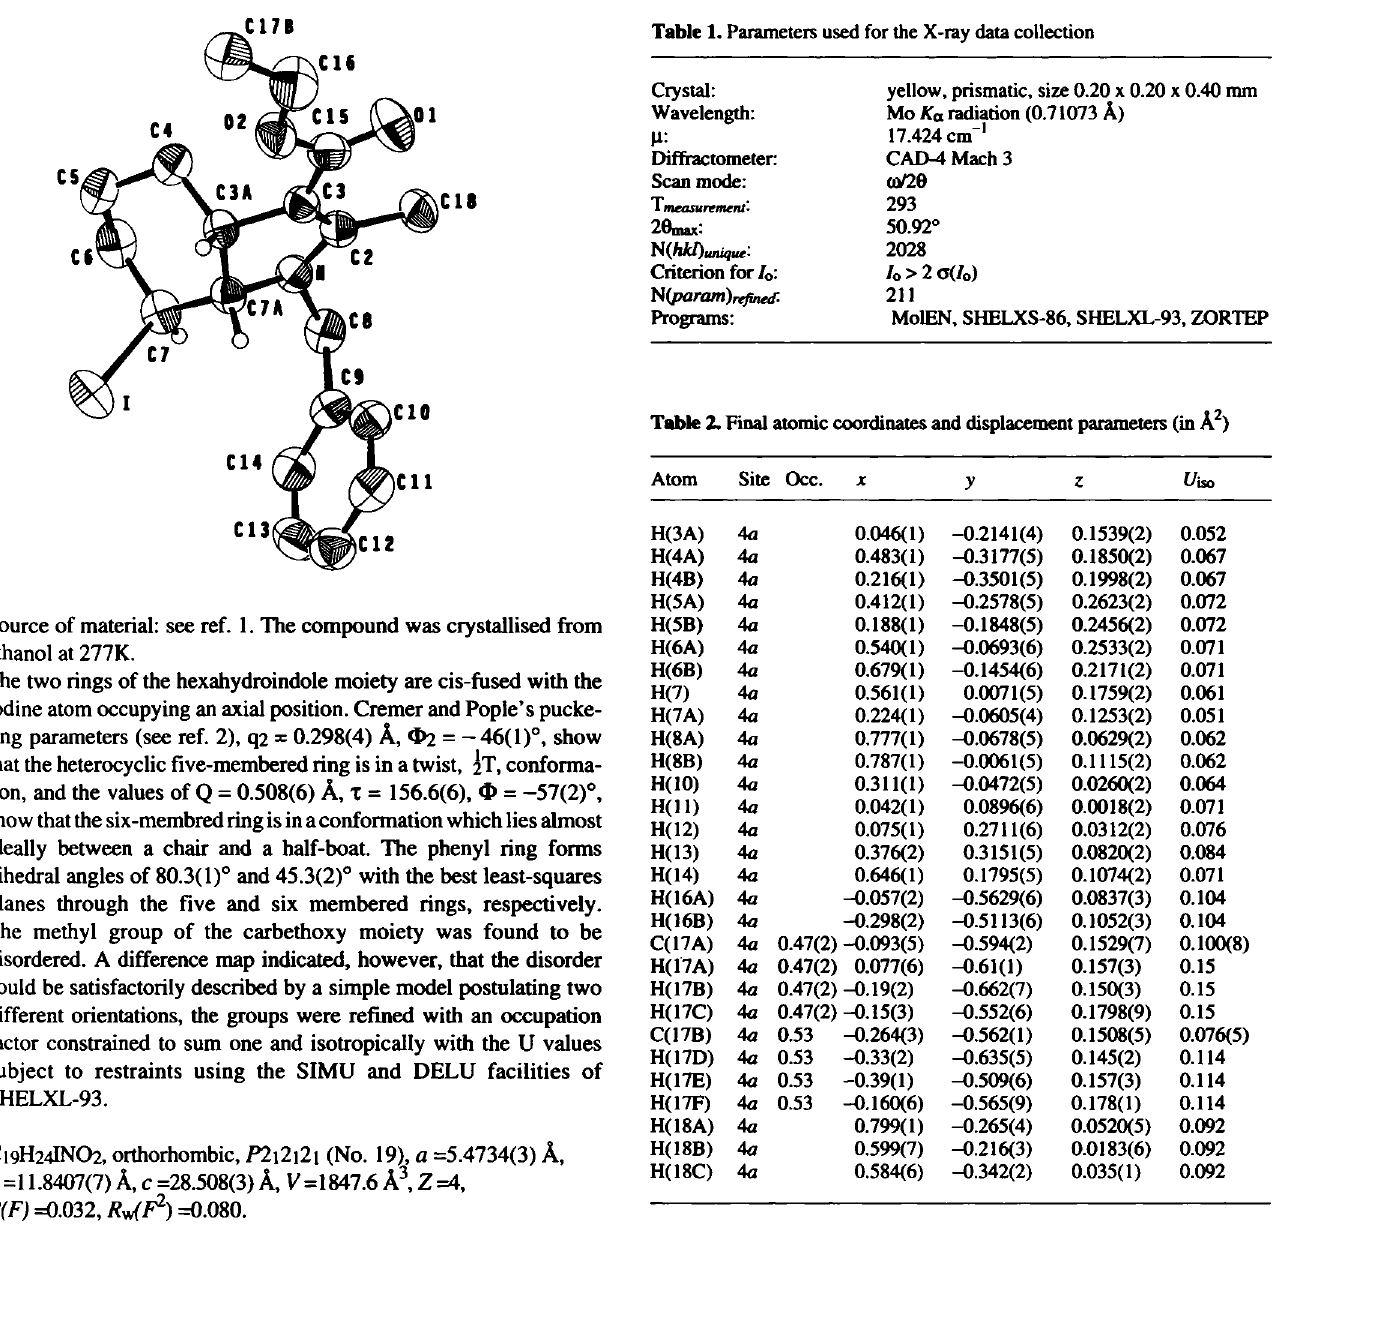
Table 1. Parameters used for the X-ray data collection